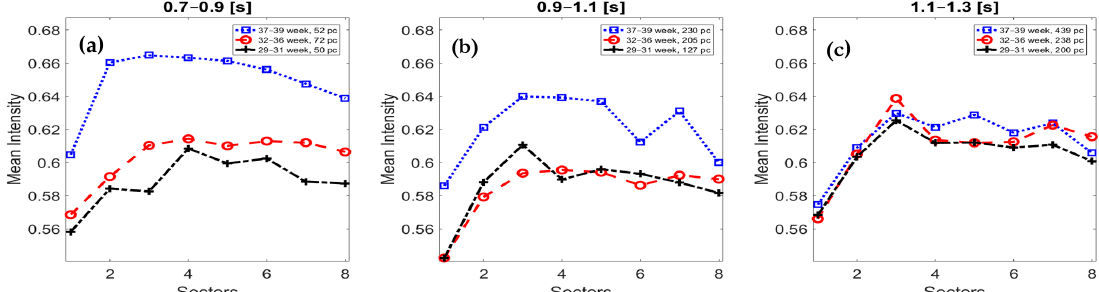
Figure 3. The sector intensity of the fetal breathing movement (FBM) episodes is depicted according to the gestational ages and the episode length. The subfigure ( a ) refers to the shorter episodes (0.7–0.9 s), ( b ) to the medium-sized (0.9–1.1 s) ones, and ( c ) shows the longer episodes (1.1–1.3 s). The lines mark the different gestational ages, where the black dashed line refers to 29–31 weeks, the red circled line means 32–36 weeks, and the blue squared line is between 37 and 39 weeks.